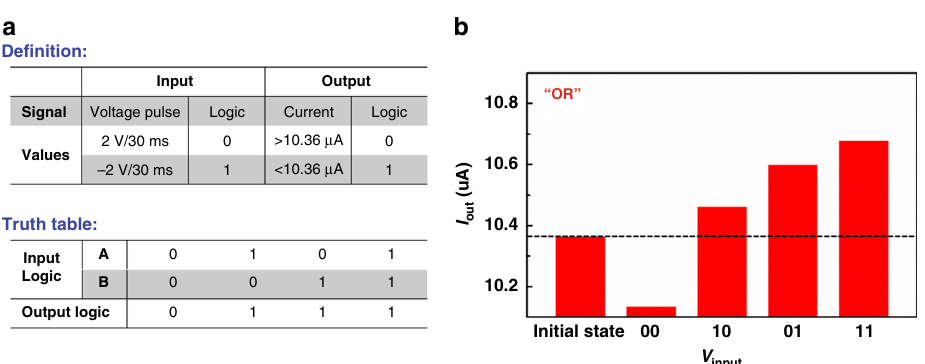
Fig. 7 Realization of the OR logic gate function with PFTPA-Fc memristor. a De fi nition for the logic inputs/outputs and truth table. b Experimental results of the